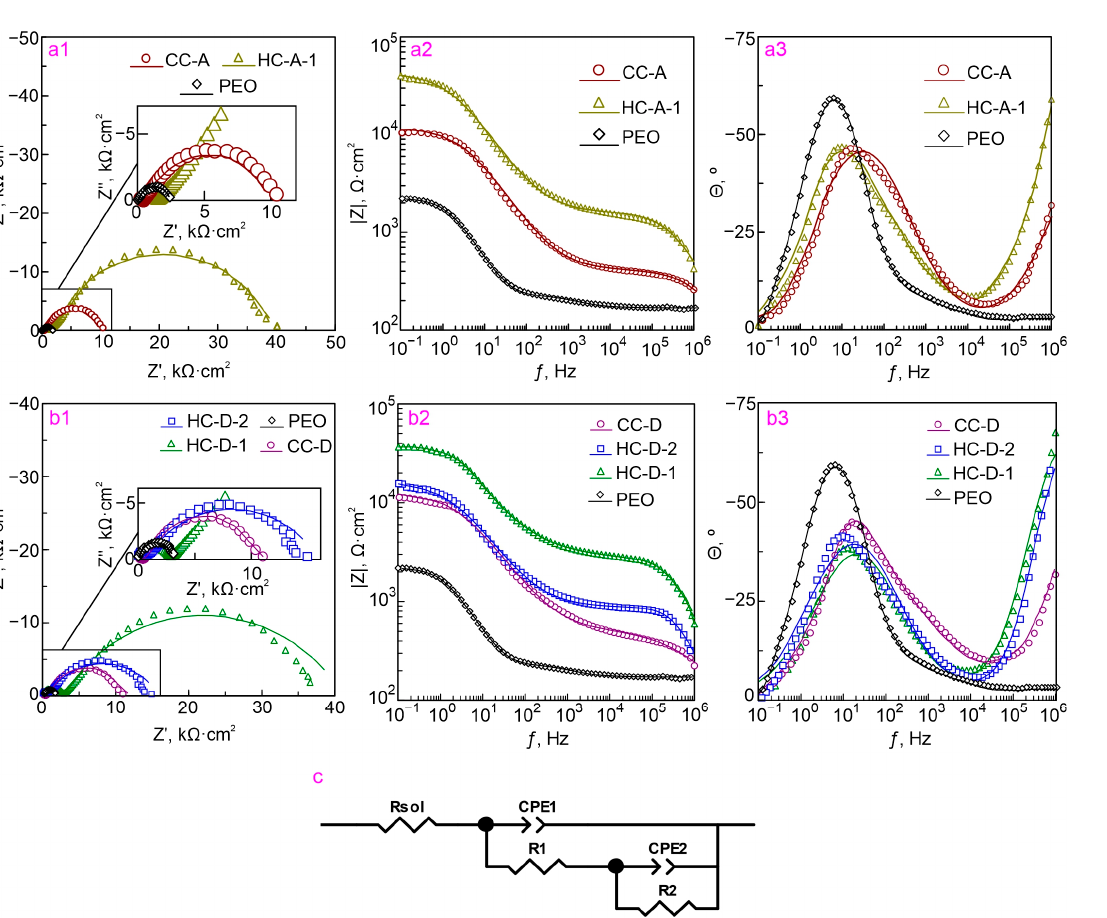
Figure 10. Impedance spectra Nyquist ( a ) and Bode plots ( b , c ) for the studied samples acquired after 22 h of exposure to 3.5 wt.% NaCl solution. The evolution of the calculated parameters of EEC elements for samples with differ- ent types of coatings formed on the MA8 magnesium alloy during 22 h of exposure to 3.5% NaCl solution is presented in Tables 2 and S1–S3. Parameters Q and n ( CPE constant and exponential factor, respectively) during the immersion of the sample vary slightly, which indicates a slight change in the morphology, composition, and properties of the